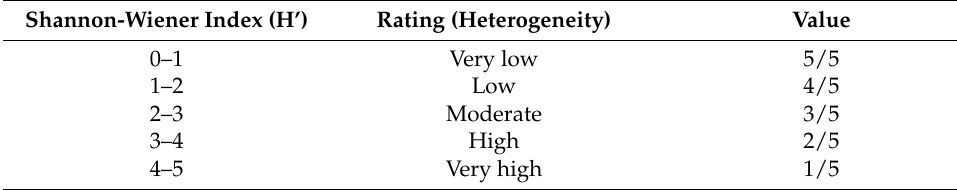
Table A4. Landscape assigned values.